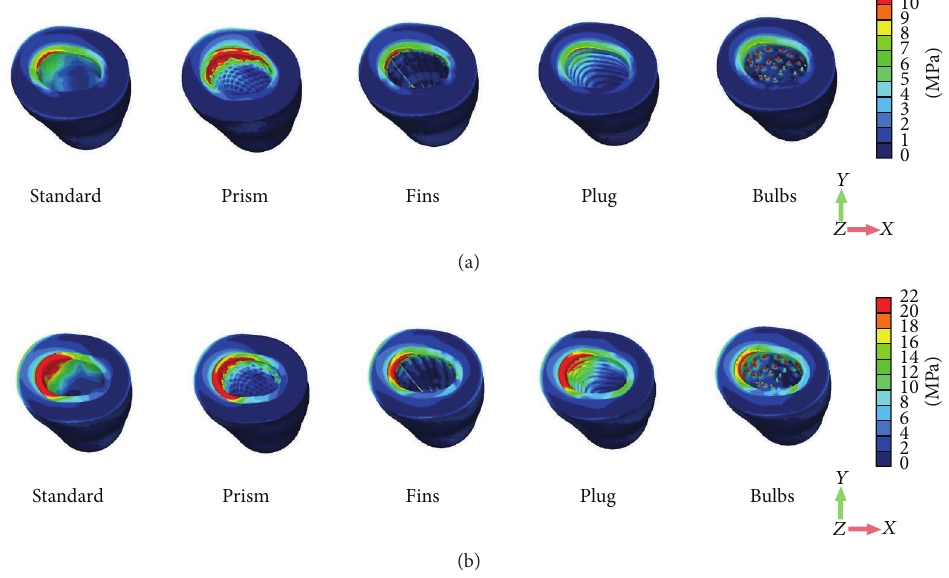
Figure 5: Distribution patterns of von Mises stress under vertical (a) and oblique (b) loading components.